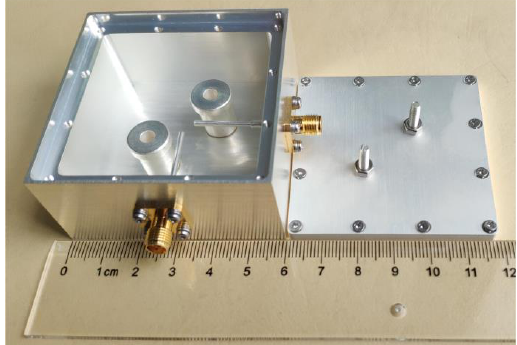
Figure 9. Fabricated quadruple-mode filter. Table 1. Comparison among similar cavity filters.